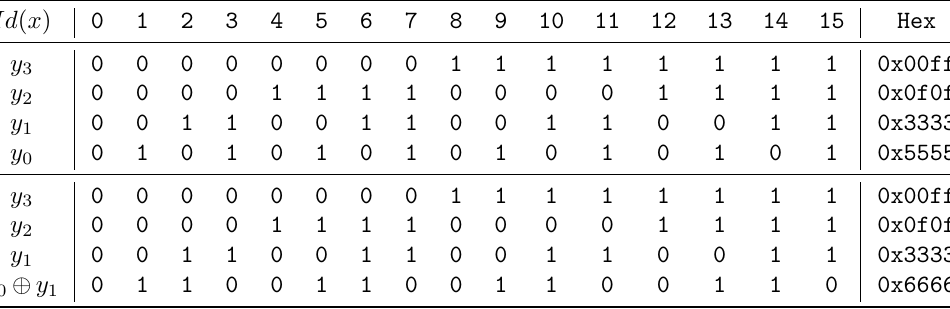
Table 2: Bit-sliced representation of the identify function Id , and example of an application of the instruction y 0 ← y 0 ⊕ y 1